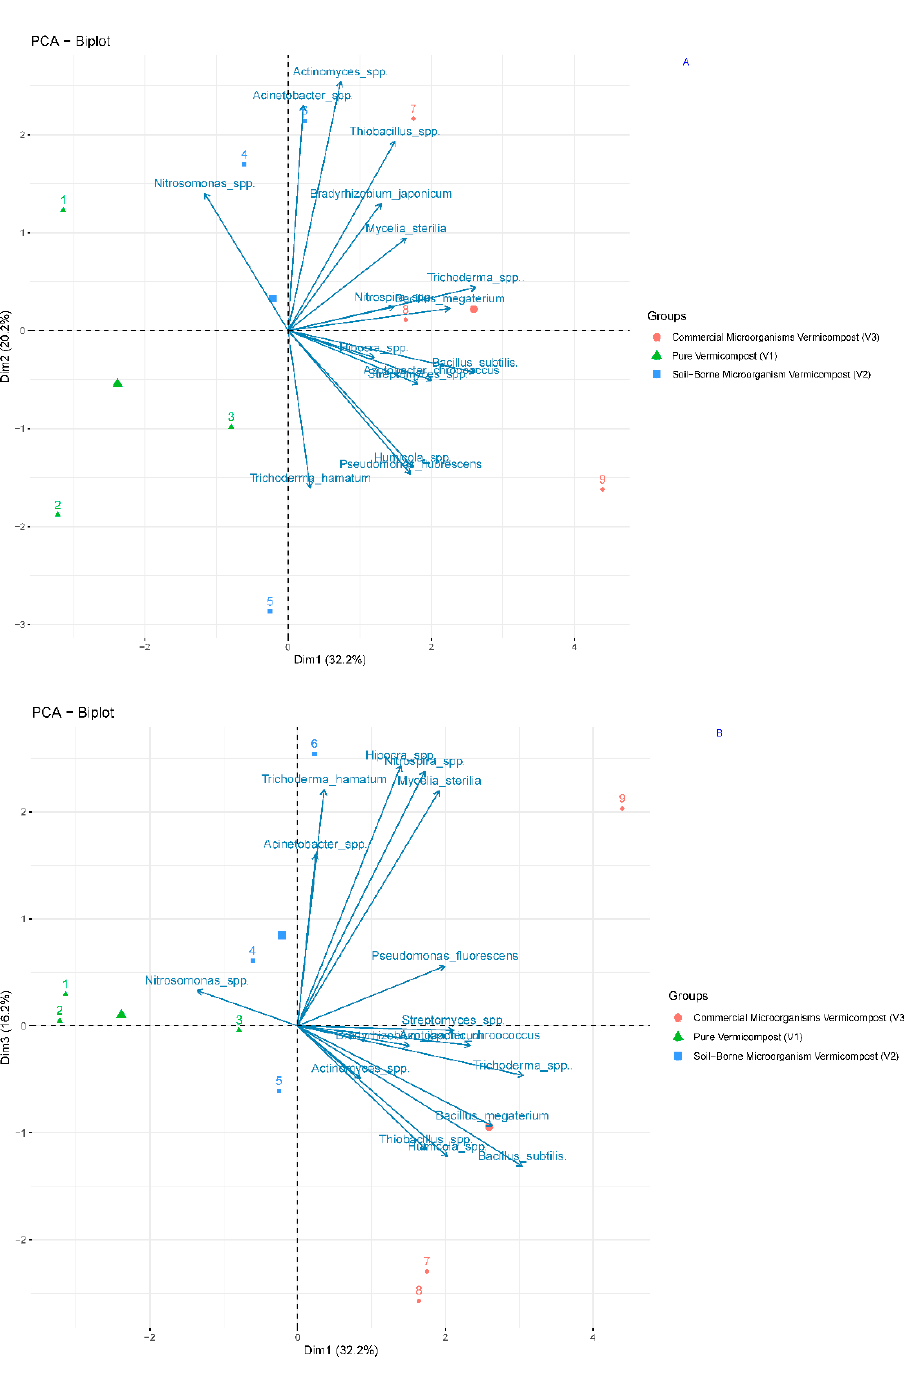
Figure 2. Principal components analysis for microbial assessment ( A ) and ( B ) of the three vermi- composting formulations. 1: vermicompost without inoculation (V1); 2: soilborne microorganisms vermicompost (V2); 3: commercial microoganisms vermicompost